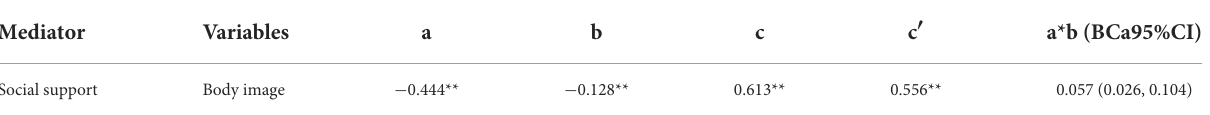
TABLE 4 Mediating role of social support between body image and depressive symptoms.